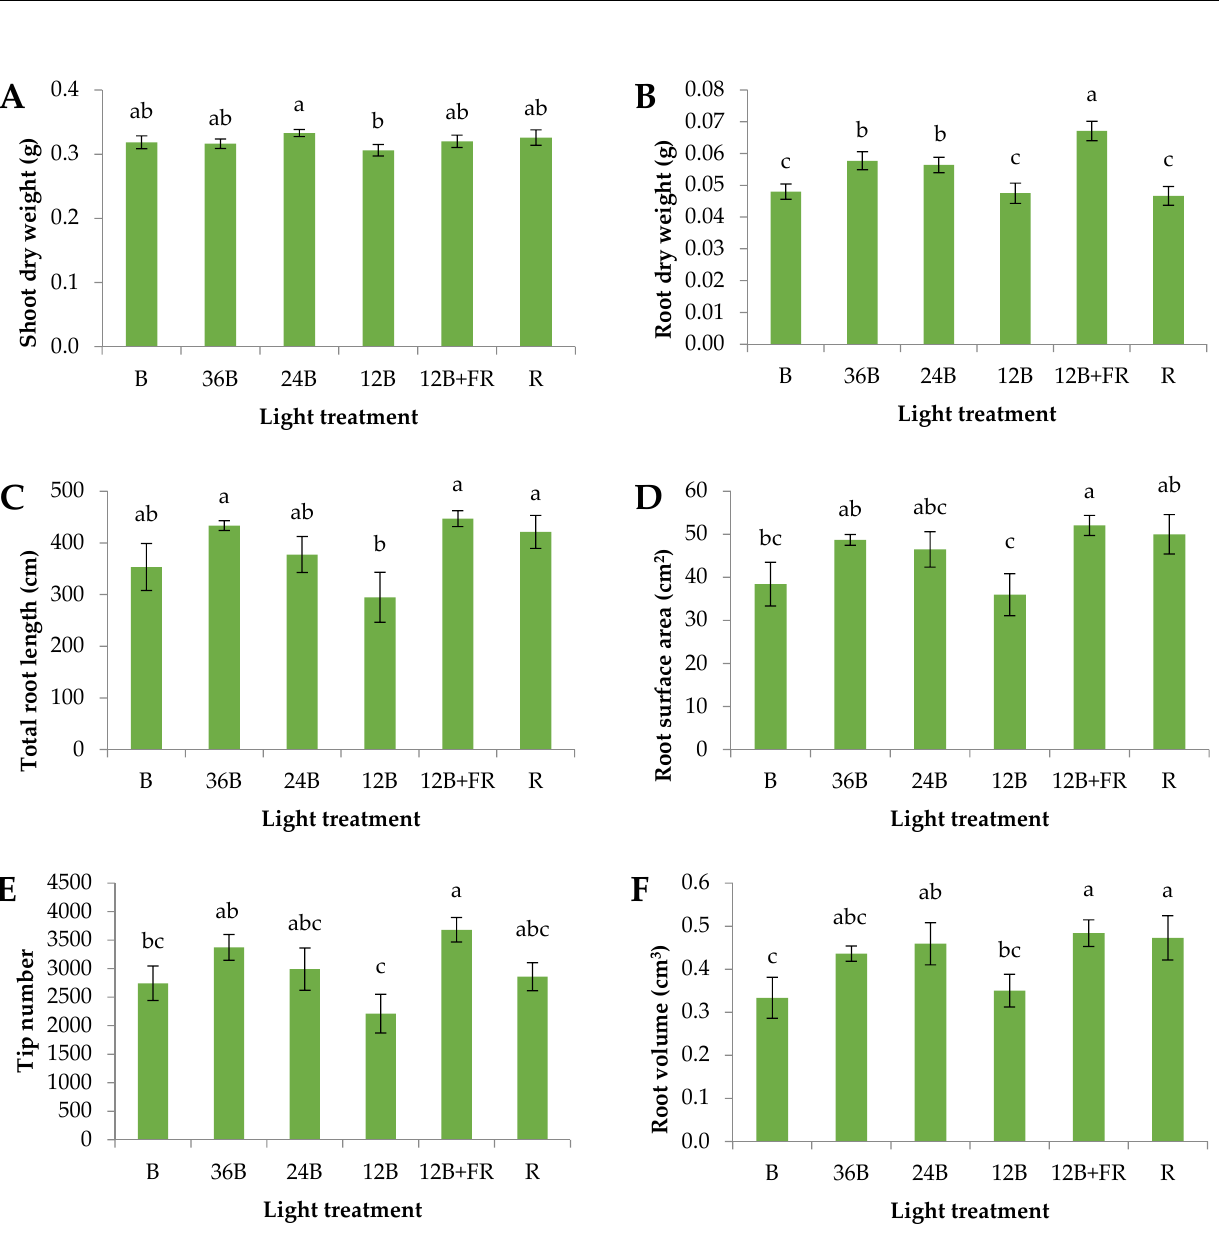
Figure 2. ( A ) Shoot dry weight, ( B ) root dry weight, and root architecture parameters such as ( C ) total root length, ( D ) root surface area, ( E ) tip number, and ( F ) root volume of grafted watermelon seedlings treated for seven days in a healing chamber with six light treatments, plus seven days in a greenhouse. Mean values ( ± SE) within a row followed by different letters are significantly different (a < 0.05).